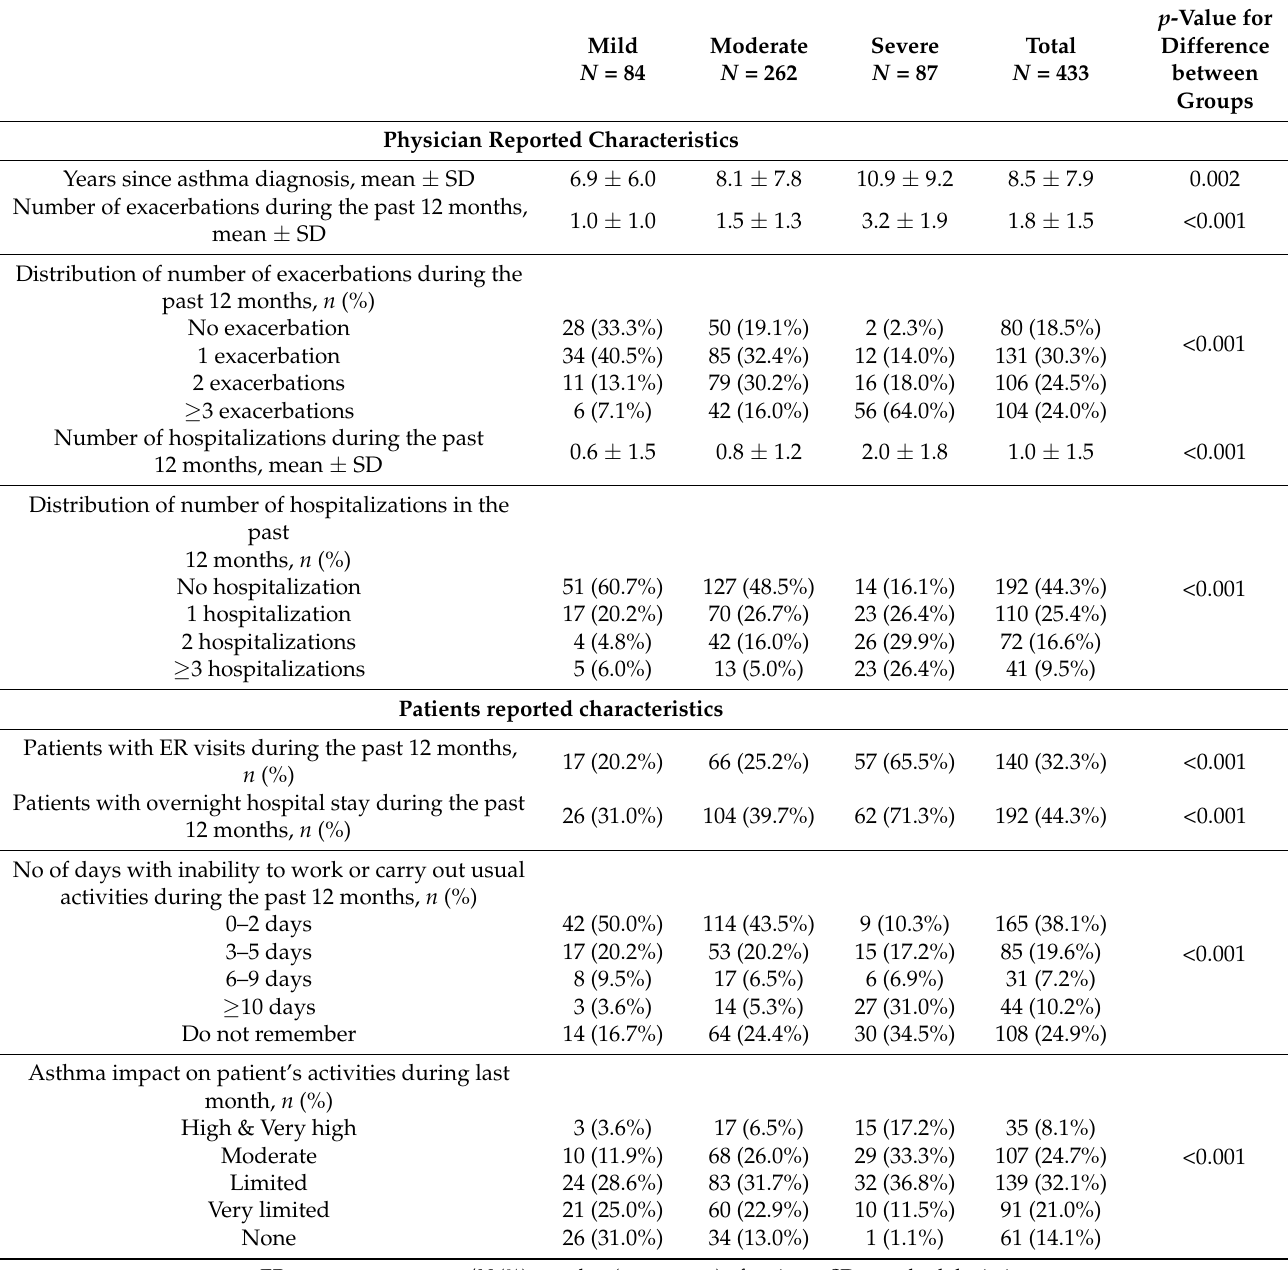
Table 2. Clinical characteristics of patients and indicators of asthma symptoms and exacerbations according to asthma severity.